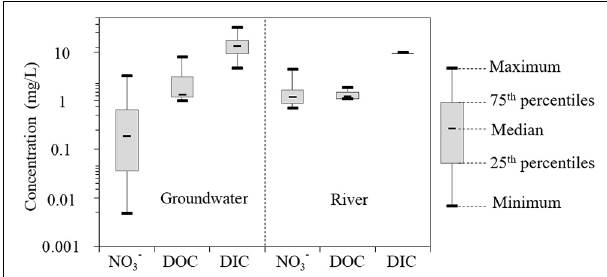
FIGURE 4 | Concentrations of nitrate (NO 3 − ), dissolved organic carbon (DOC), and dissolved inorganic carbon (DIC) in coastal groundwater and river water samples.